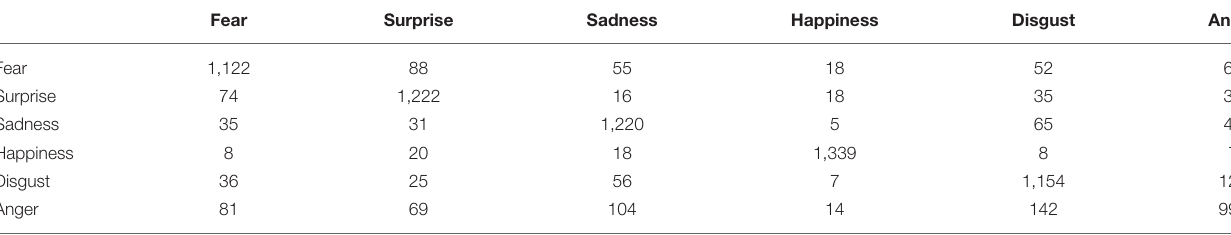
TABLE 3 | The confusion matrix of recognizing facial expressions for healthy controls.